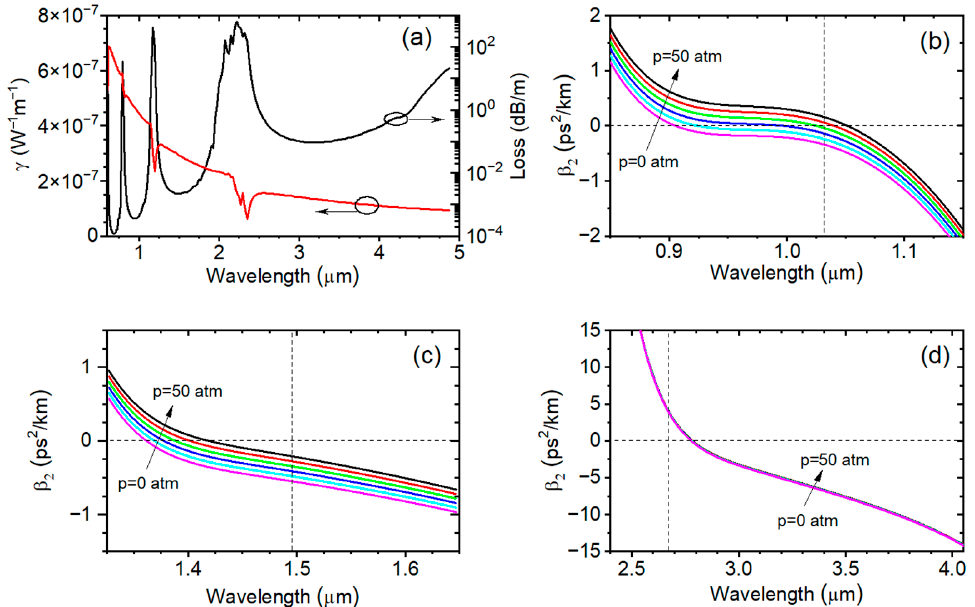
Figure 2. ( a ) The optical loss spectrum (black) and nonlinear coefficient γ (red) calculated for the fundamental mode of the HCF. ( b – d ) Quadratic dispersion β 2 as a function of wavelength in different transmission windows of the HCF. Both waveguide and gas dispersion were taken into account. Dispersion data are presented for D 2 pressures from 0 to 50 atm with a step of 10 atm.